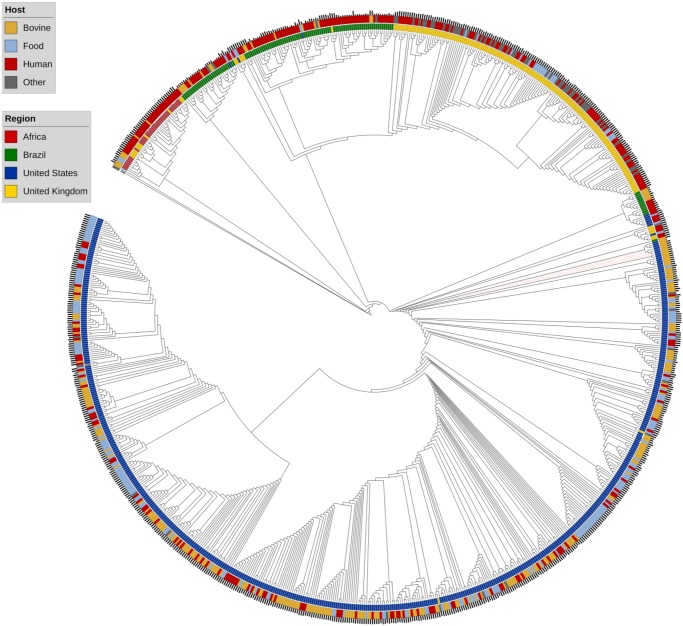
—Global population structure of S. Dublin illustrated with a maximum-likelihood cladogram, GTR Gamma model, of 880 S. Dublin genomes rooted to S. Enteritidis (AM933172). The tree is inferred from an alignment of 4,098 core genes defined by Roary. Leaves are colored respective to the region of isolation. The outer colored ring denotes isolation source. The outermost barplots illustrate data of isolation and are scaled such that the higher the bar, the more recent the isolate was cultured and zeroed to a date of 1980. Genomes cluster into distinct clades associated with the area of isolation.